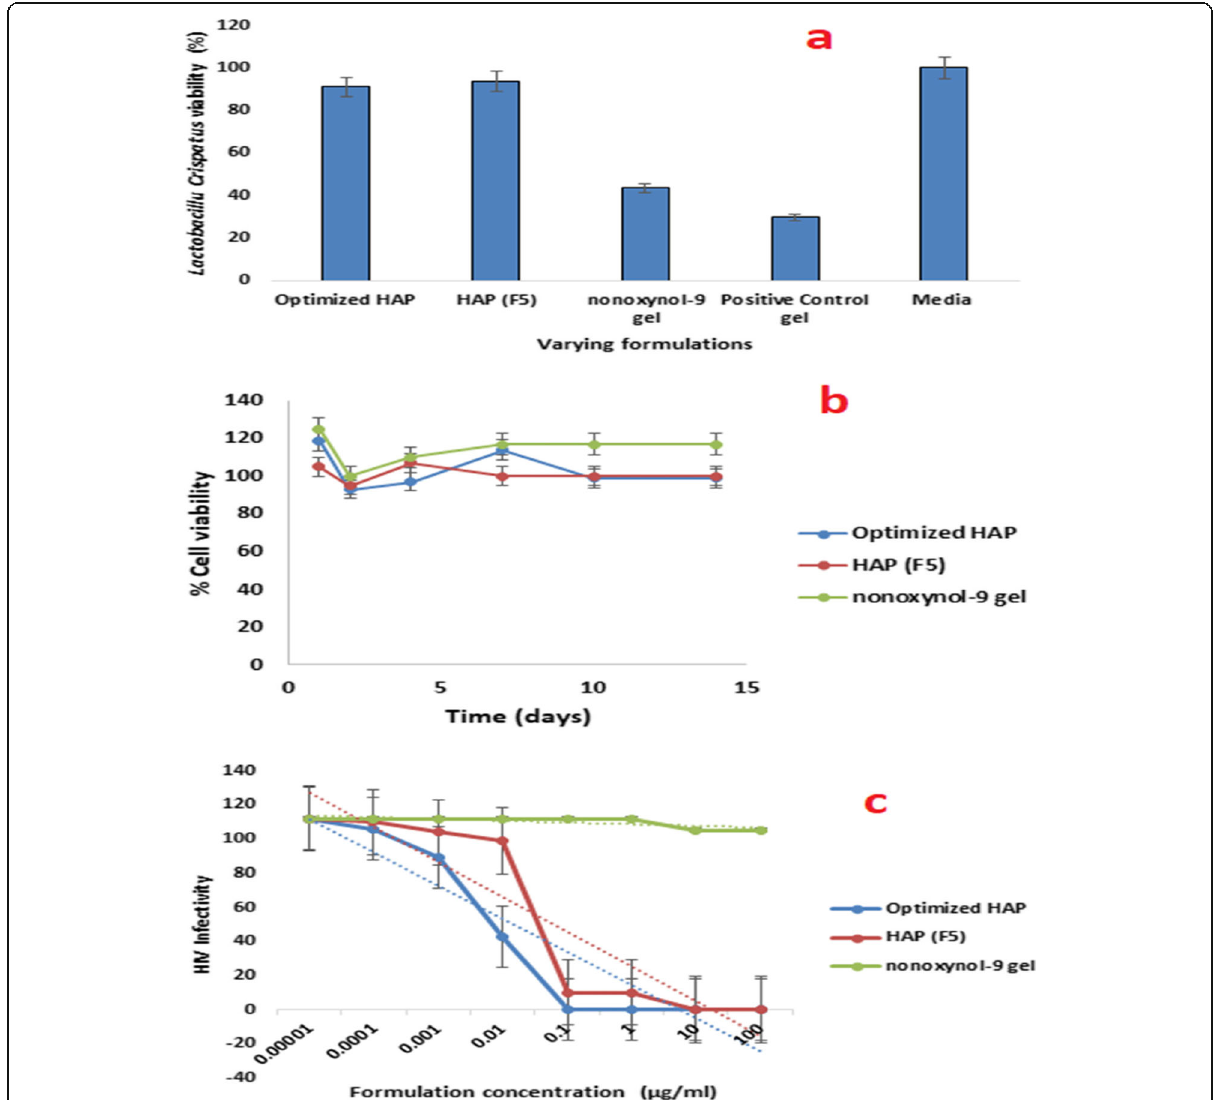
Fig. 5 a Lactobacillus viability assay after 48 h of incubation ( n = 3 ± SD). b HeLa cell cytotoxicity of optimized hyaluronic acid-palm oil (HAP)- based organogel and hyaluronic acid palm oil (HAP)-based organogel with HeLa cells over 14 days in vitro. Results are expressed as % cell viability compared to HeLa cells without any treatment ( n = 3 ± SD). c HIV infectivity dose-response curves for optimized HAP, HAP and nonoxynol gel incubated with HIV-1 indicator TZM-bl cells at different concentrations ( n = 5 ±